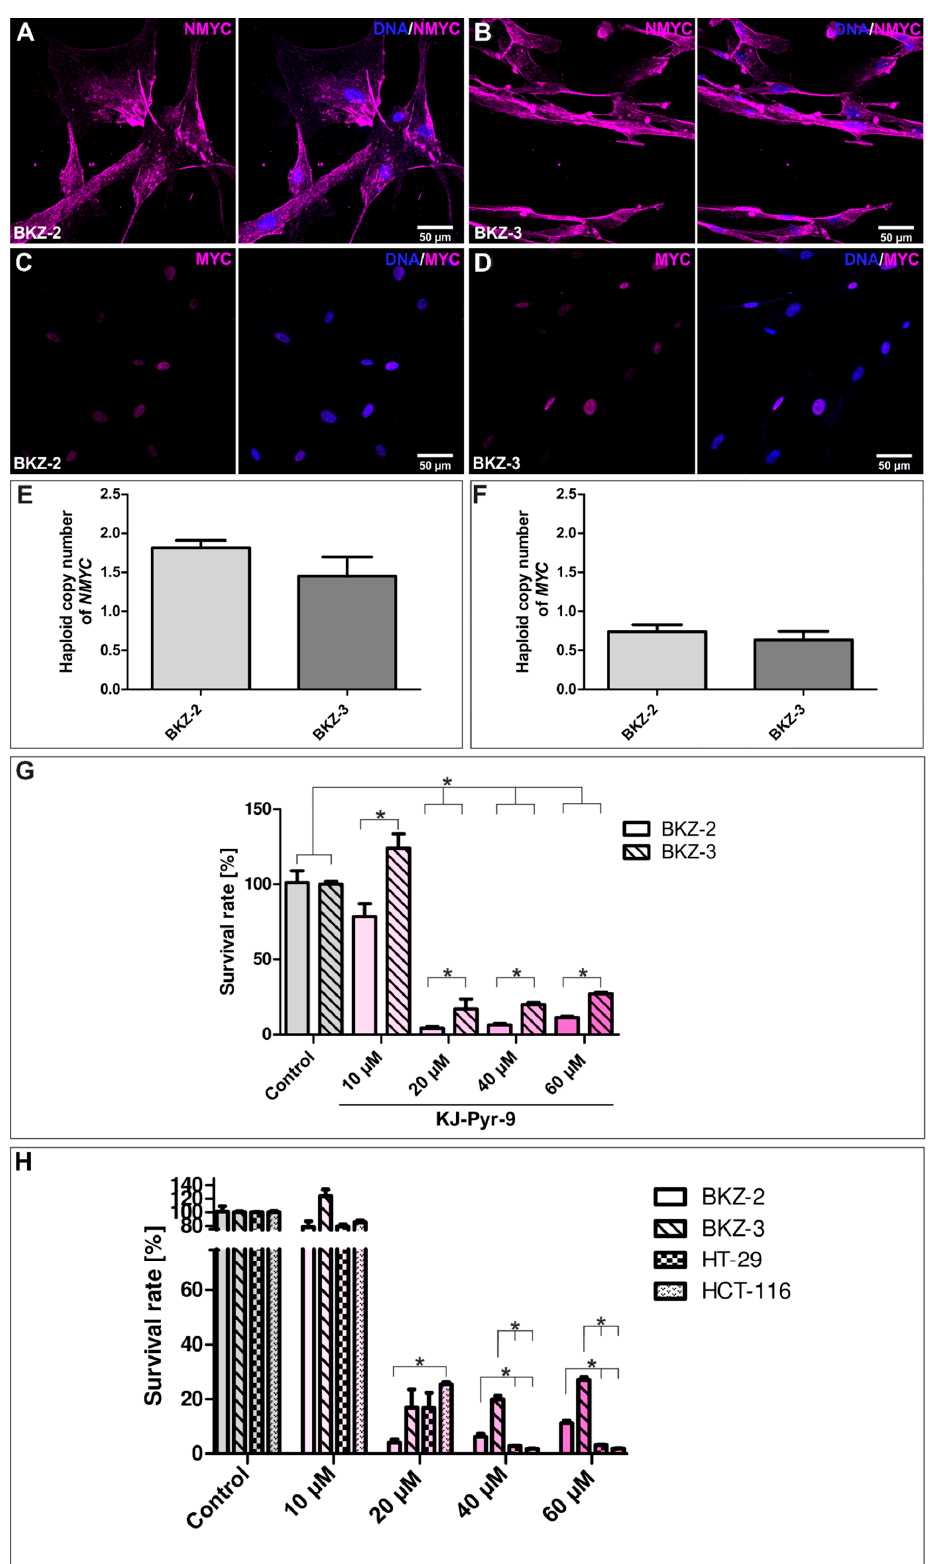
Figure 11. Inhibition of the myc proto-oncogene protein (MYC) and N-myc proto-oncogene protein (NMYC) significantly decreases the survival rate of BKZ-2 and BKZ-3 cells. Immunocytochemical